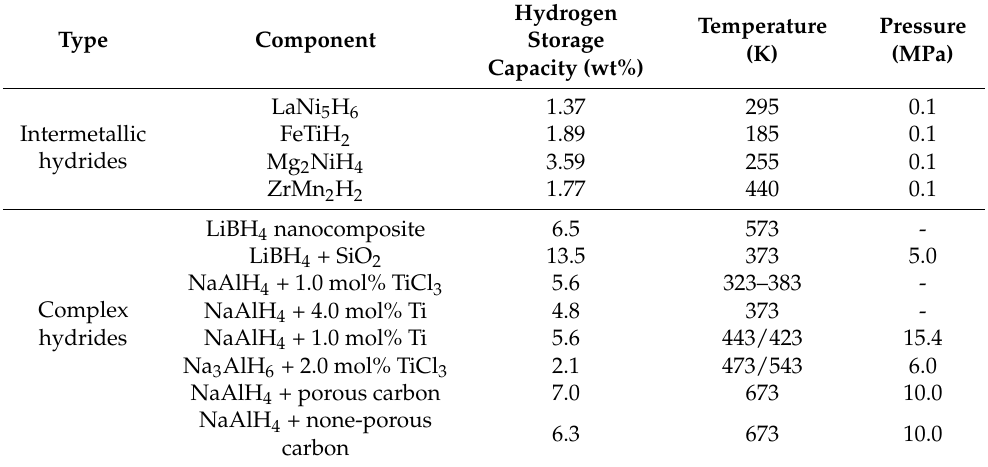
Table 8. Properties of some metal hydrides